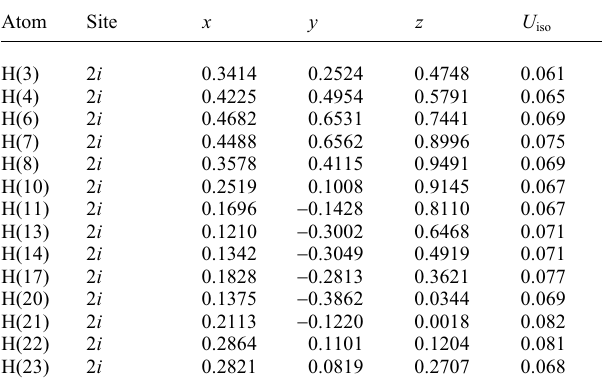
Table 2. Atomic coordinates and displacement parameters (in Å 2 )